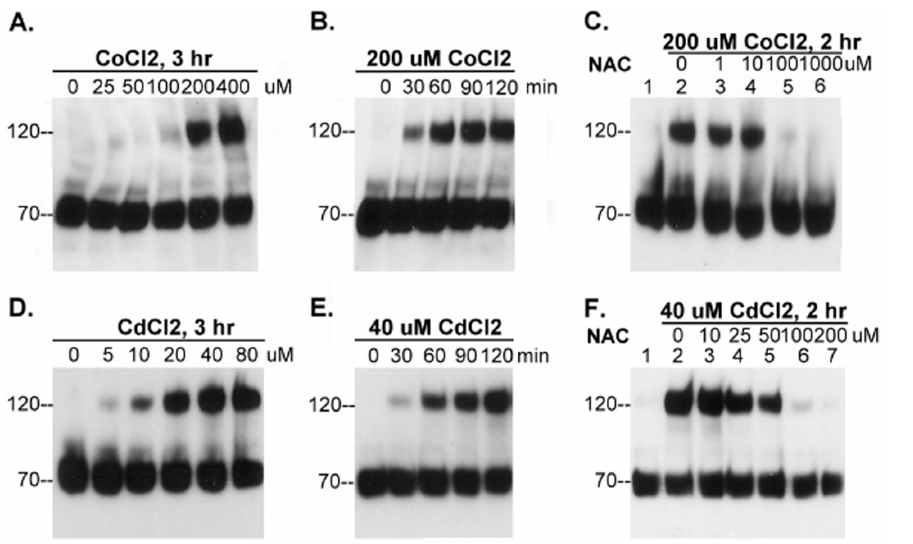
Figure 6. Matriptase zymogen activation can be induced by metal ions. ( A and D ) 184 A1N4 cells were incubated with increasing concentrations of CoCl 2 ( A ) and CdCl 2 ( D ), as indicated, at 37 u C for 3 hrs in a CO 2 incubator. ( B and E ) 184 A1N4 cells were incubated with 200 m M CoCl 2 ( B ) or 40 m M CdCl 2 ( E ) at 37 u C in a CO 2 incubator for indicated times. ( C and F ) 184 A1N4 cells were incubated with 200 m M CoCl 2 (C) or 40 m M CdCl 2 (F) in the presence of increasing concentrations of N-acetylcysteine (NAC), as indicated, at 37 u C in a CO 2 incubator for 2 hrs. Cell lysates were prepared and assayed by immunoblot analyses for matriptase activation using mAb M24 as before.